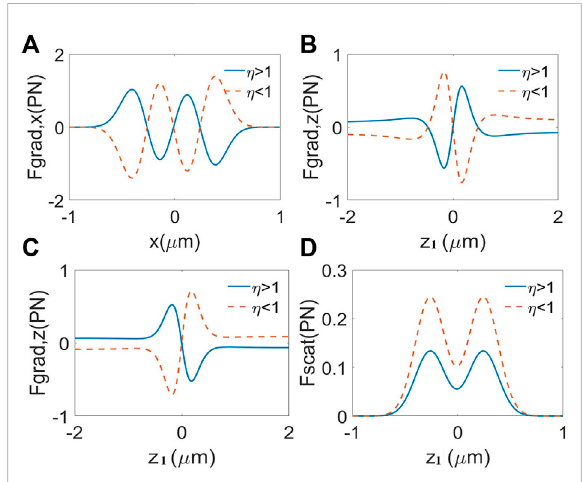
FIGURE 4 Effects of the refraction index on the radiation forces. The high-indexparticle( η > 1)insolidlines,thelow-indexparticle( η < 1) in dashed lines. (A) , (B) and (D) at the focus, x = 0 μ m, (C) at the points of x = ±0.3 μ